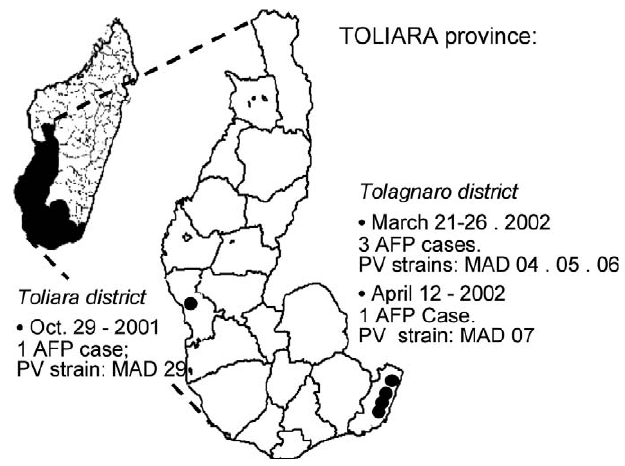
Figure 1. Map of the Toliara Province in Madagascar This map indicates the location of the two districts where the poliomyelitis outbreaks occurred. Names of the PV strains isolated from the patients with AFP are indicated.